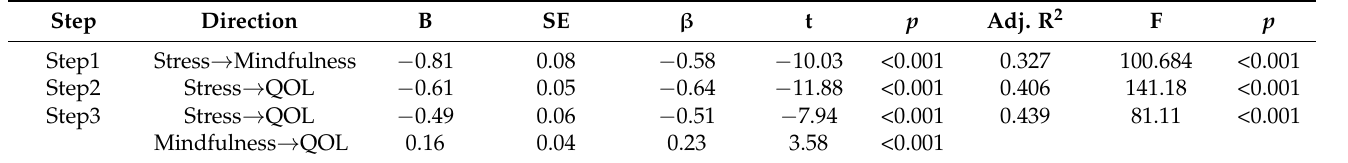
Table 4. Mediating effect of mindfulness ( N = 206).